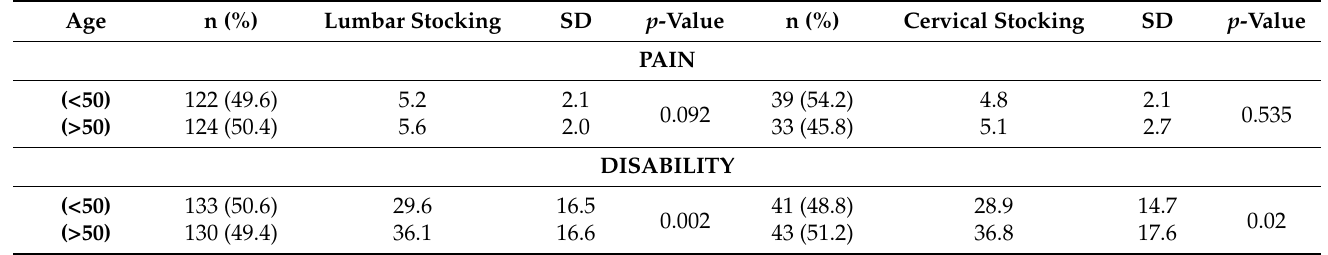
Table 3. First evaluation of the BS: pain and disability as a function of age in construction workers.